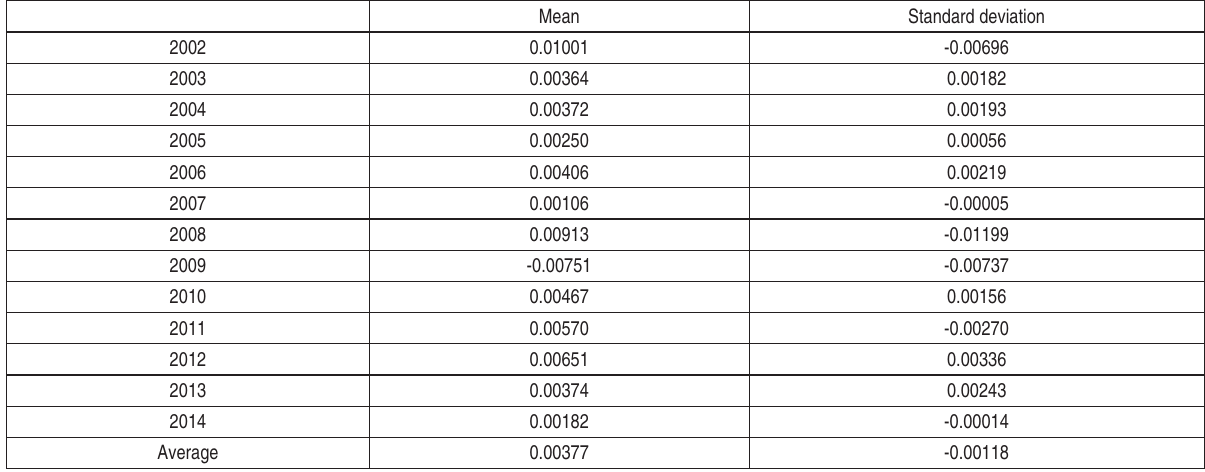
Table 4. Difference in returns and standard deviations, VIX minus